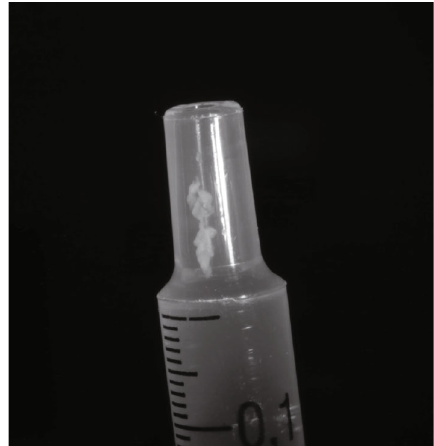
Figure 2: After removing the fi lter cannula, a kind of clot was observed that had not previously been seen on the syringe supplied.